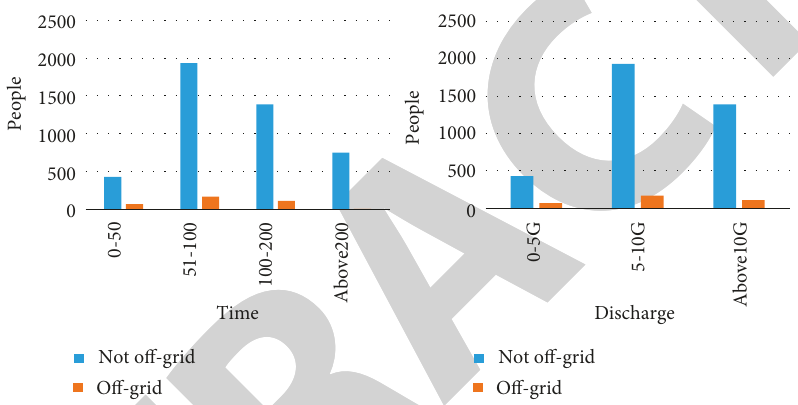
Figure 13: Statistics on customer churn based on average monthly call charges and different traffic. Table 3: Logistic regression results.